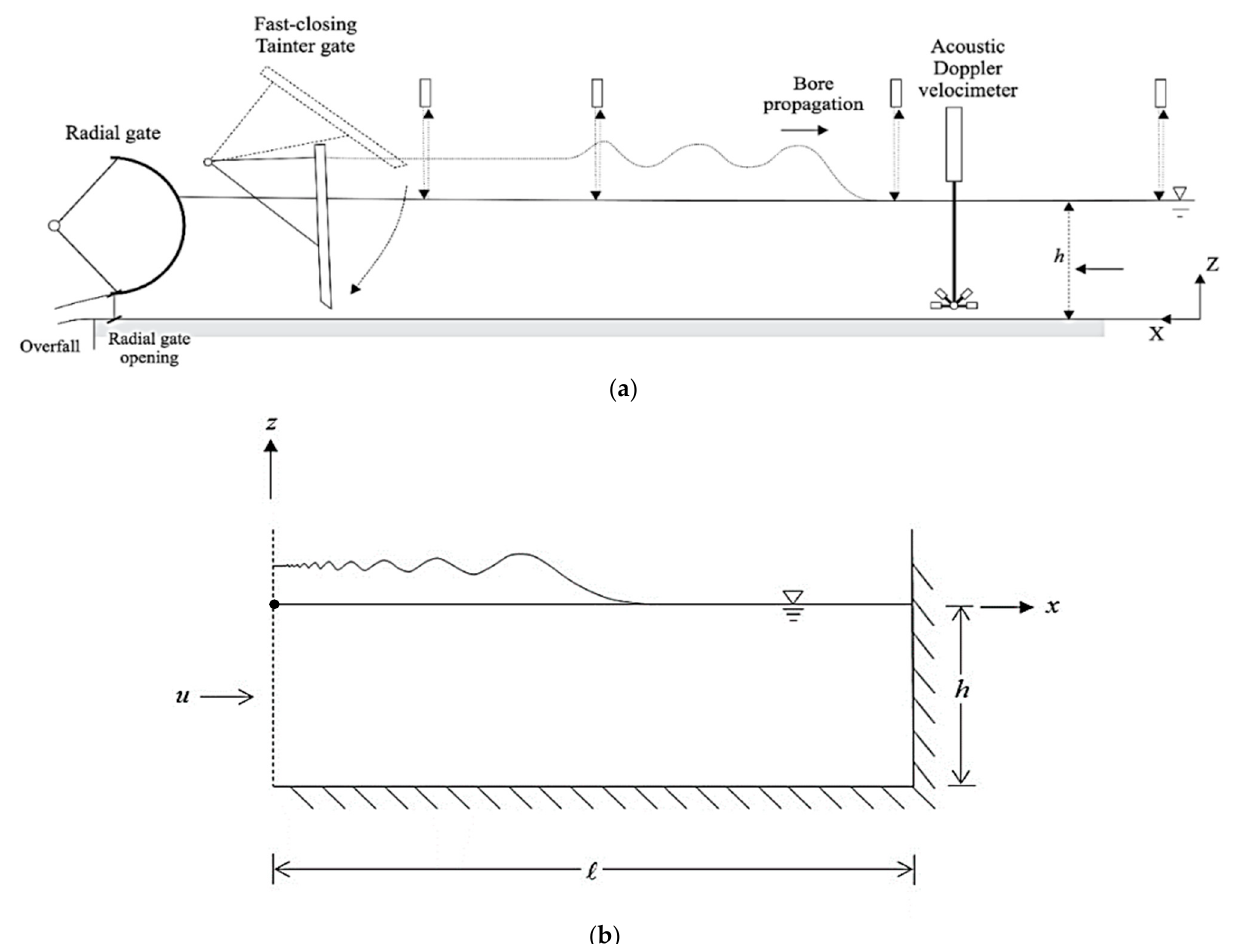
experimental data analysis, were described in [7]. The schematic diagram of the experimen- ary.